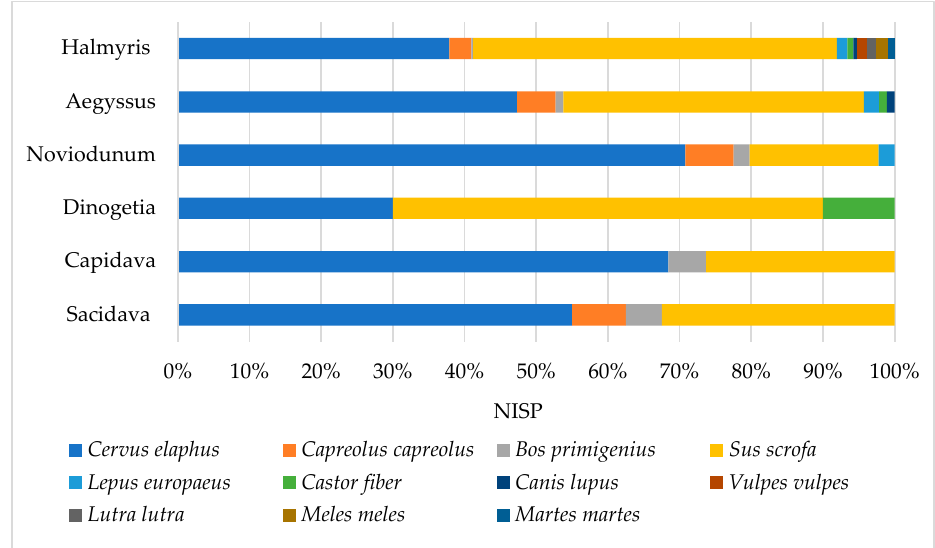
Figure 3. Proportions of species in the wild mammal group.